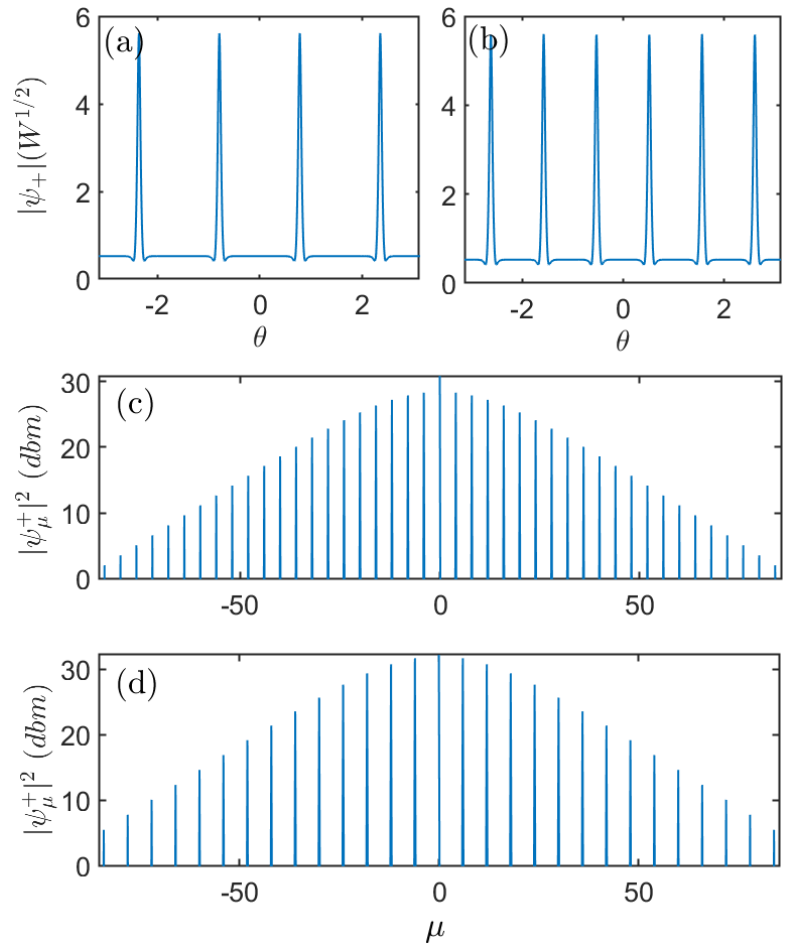
Figure 5. Soliton crystal states for ε /2 π = 1 MHz. ( a , b ) are the spatial profiles and ( c , d ) are the respective spectra. The other parameters are as in Figure